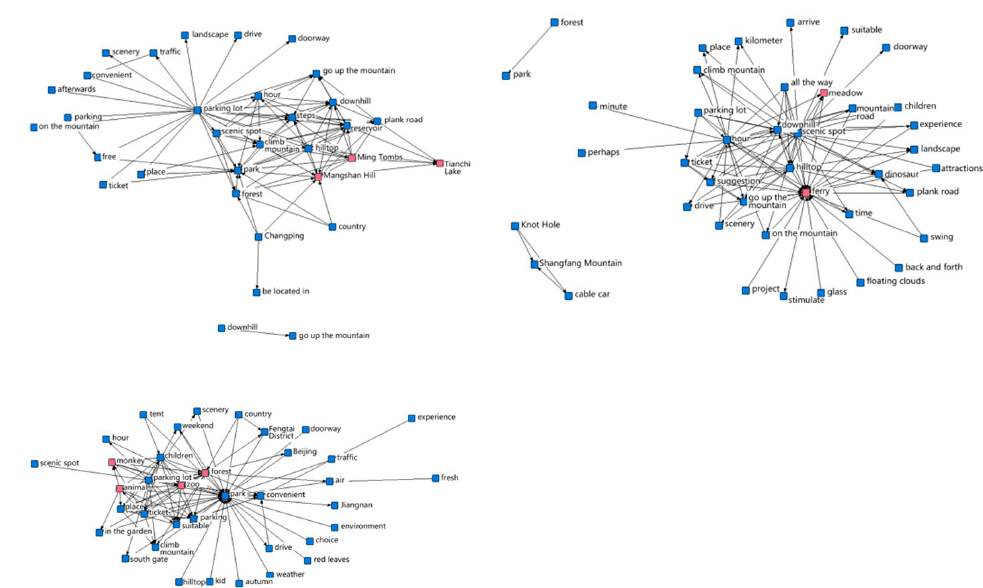
Figure 17. The semantic web of mountain landscapes in various administrative regions (From left to right: Changping District, Fangshan District, and Fengtai District).